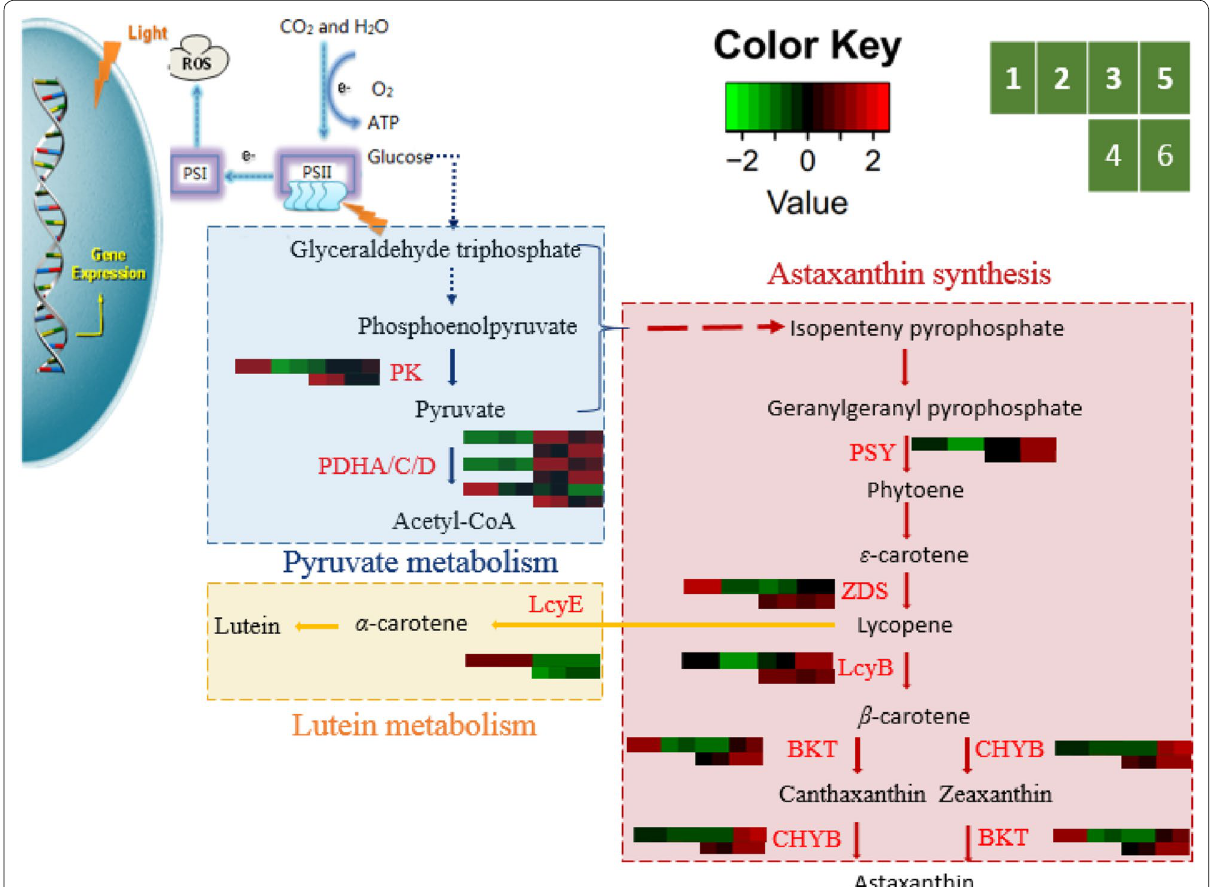
Fig. 4 The metabolism network and transcription regulation of astaxanthin metabolism. Deep red, dark blue and bright yellow background represent astaxanthin metabolism pathway, pyruvate metabolism pathway and lutein metabolism pathway, respectively. Solid arrows indicate that the reaction proceeds continuously, dotted arrows indicate that intermediate metabolites are omitted. 1235 and 1246 represent Sample 1, Sample 2, Sample 3 and Sample 5 of control group (1235 route) and Sample 1, Sample 2, Sample 4 and Sample 6 of treatment group (1246 route), respectively. Sample 1, Sample 2 and Sample 3 were the heterotrophic cells at 100 h, 250 h, and 550 h, respectively; Sample 4 was Sample 2 cells induction for 0.5 day; Sample 5 was Sample 3 cells induction for 6 days; Sample 6 was the Sample 2 cells induction for 6 days. The number of replications is two ( n =